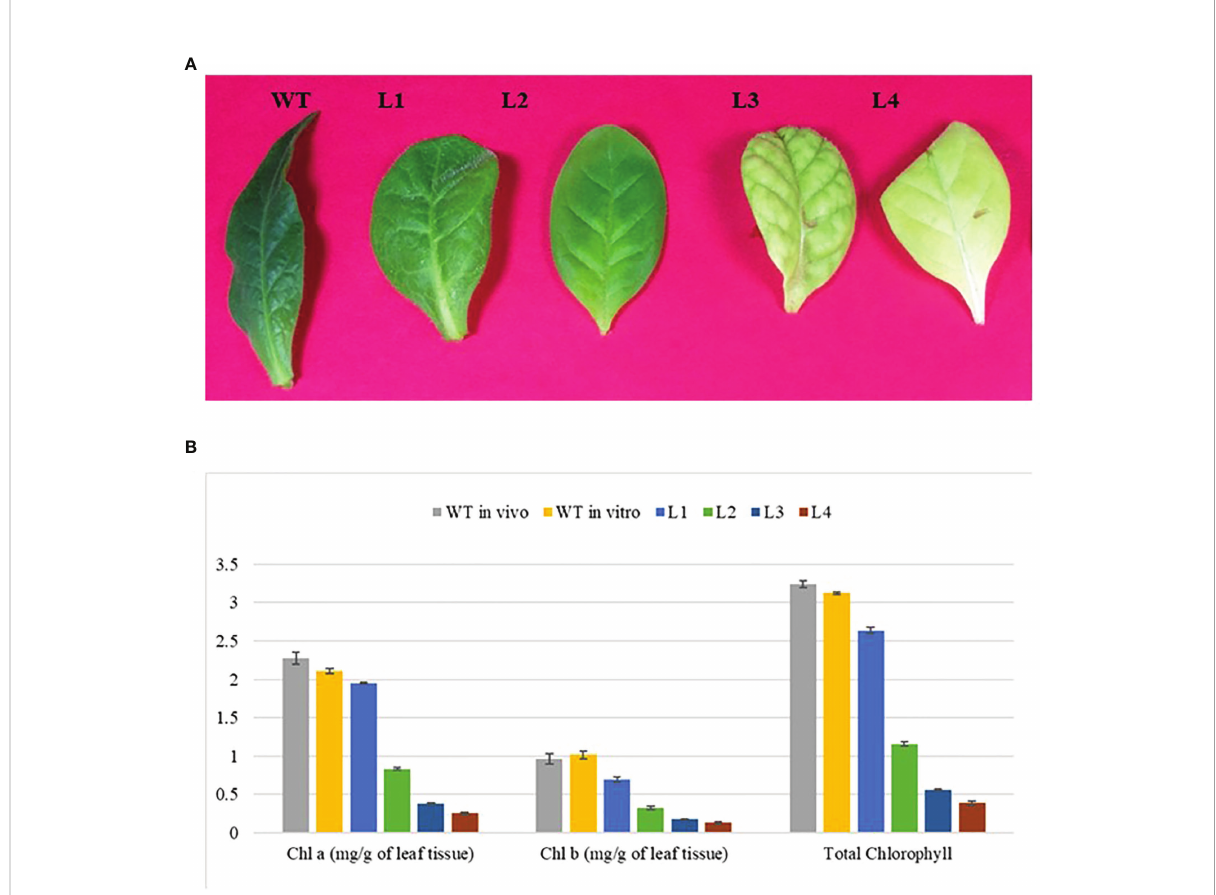
FIGURE 6 Photosynthetic performance of Δ ycf4 plants. (A) Leaves samples used for chlorophyll estimation (B) Graphical representation showing chlorophyll content in wild-type and transgenic plants. The lower contents of photosynthetic pigments in the Δ ycf4 plants indicate that they were physiologically incompetent as compared with wild-type tobacco plants. WT represents wild-type whereas L1, L2, L3, and L4 represent 1st, 2 nd , 3rd and 4th leaf of Δ ycf4 plants from top to bottom,